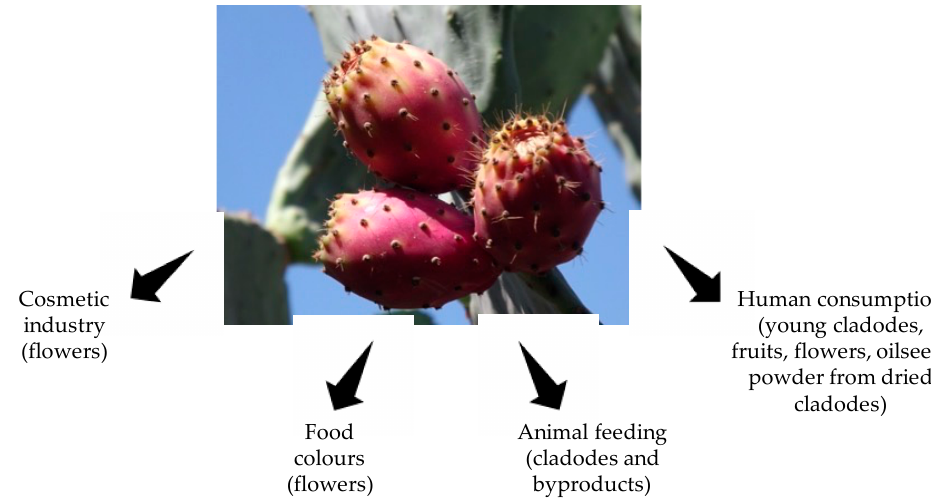
Figure 2. O. ficus-indica and its main uses.